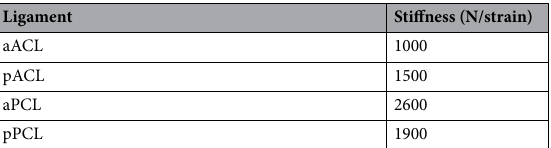
Table 2. Values of knee ligament stiffnesses assumed in the model. aACL anteromedial bundle of the anterior cruciate ligament, aPCL posterior bundle of the anterior cruciate ligament, pACL anterolateral bundle of the posterior cruciate ligament, pPCL posteromedial bundle of the posterior cruciate